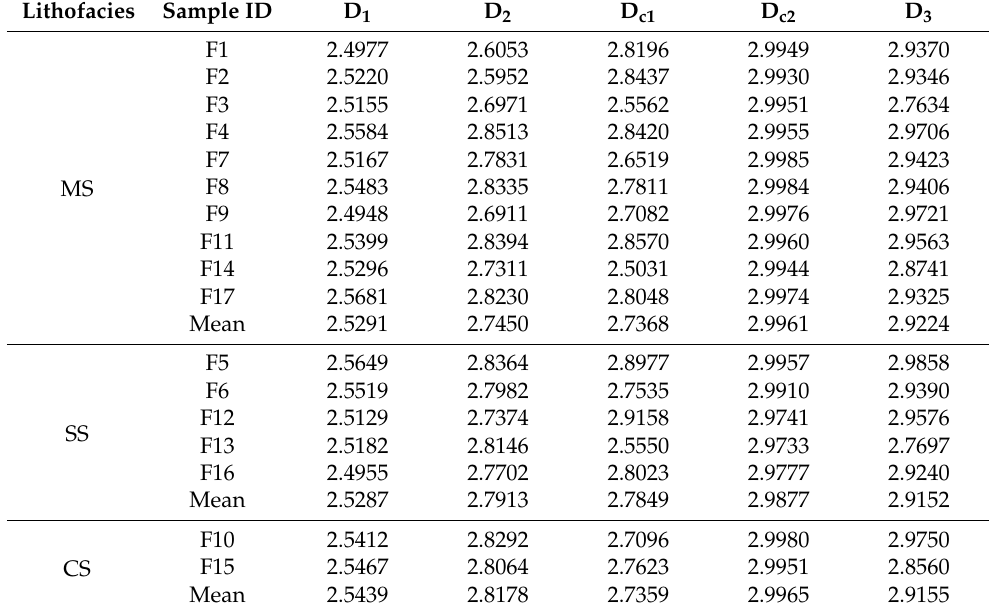
Table 3. Fractal dimensions obtained from N 2 adsorption and